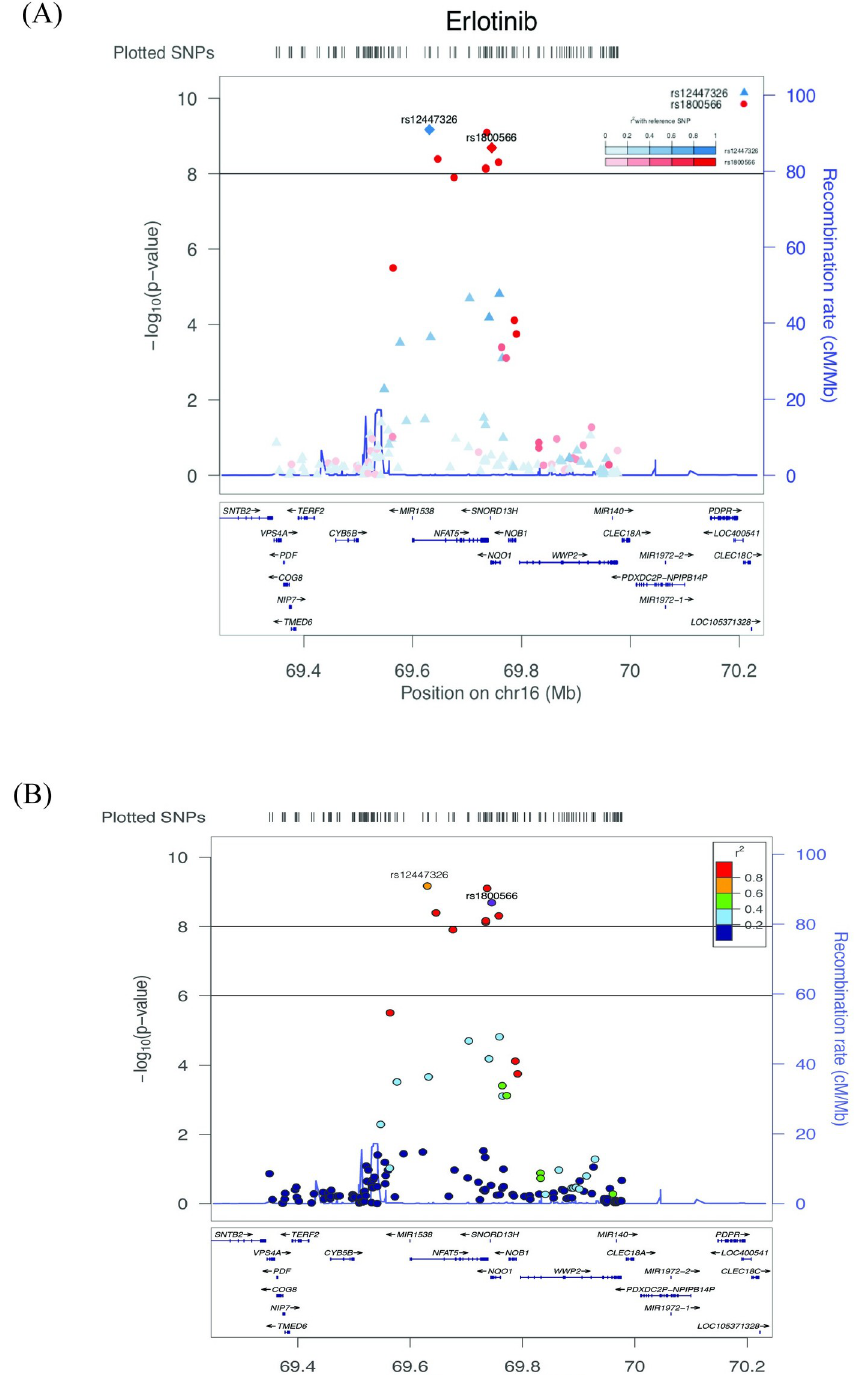
Fig 2. LocusZoom plot of the genes surrounding SNP rs1800566 on chromosome 16 for the drug erlotinib. LocusZoom plots showing the regional genes surrounding a 1 mega base pair region around SNP rs1800566 on chromosome 16 for associations with erlotinib. In the top panel, SNPs rs12447326 and rs1800566 are both used as lead/reference SNPs (shown as diamonds). For all other non-lead SNPs (shown as circles and triangles), their color and shape are matched to the lead SNP with which it is in the highest linkage disequilibrium (LD), as shown in the legend. The extent of LD with the lead SNP is shown by the color gradient. In the bottom panel, SNP rs1800566 is used as the lead SNP, and all other SNPs are colored according to their level of LD with rs1800566, as shown in the legend.